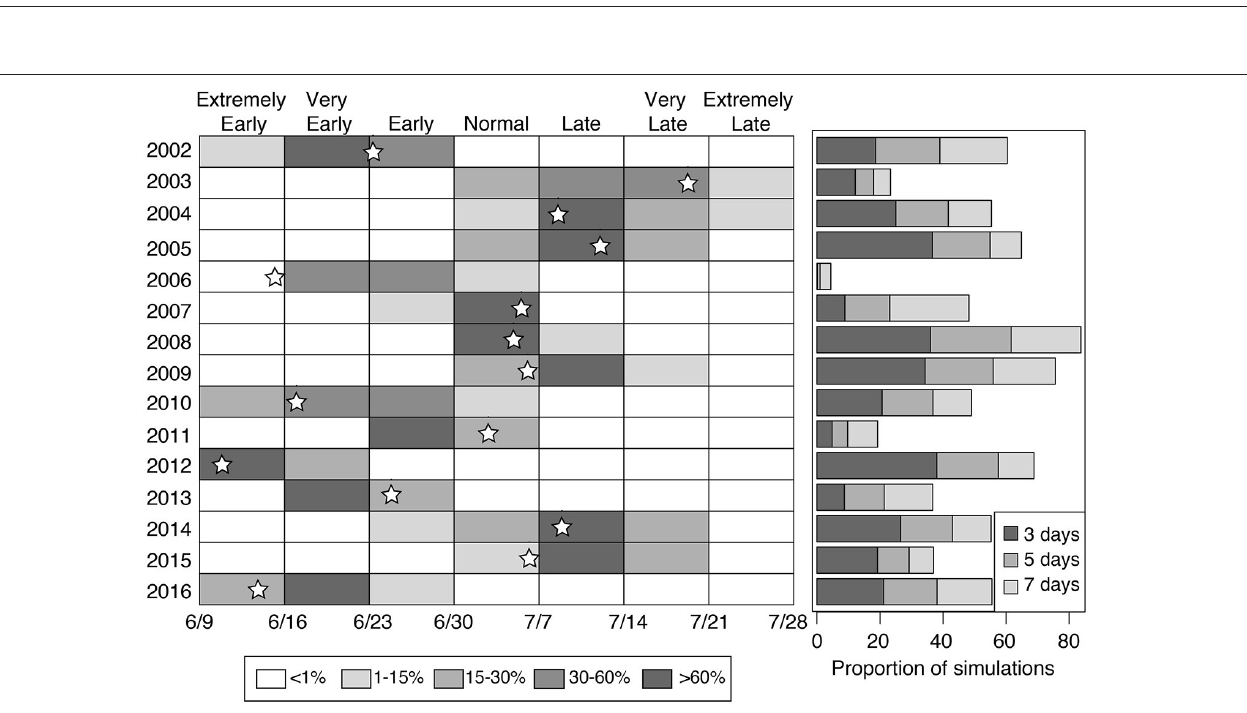
FIGURE 6 | Past performance of forecast. An April 1 forecast is run for each year 2002–2016, using all available data except the year being tested. In the left panel, the boxes represent 7-day windows, centered on a “normal” start day bin that encompasses June 30-July 7. Bins are shaded according to the percentage of simulations that predict a start day in the week represented by the bin (legend shown below panel). The observed start day is plotted as a star. In the right panel, the stacked bar plot shows the proportion of mMC simulations predicting a start day inside a 3-, 5-, and 7-day window centered on the observed start day.